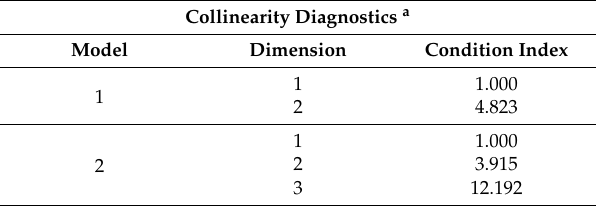
Table 7. Verification of the assumption of lack of multicollinearity between variables. D1 building.